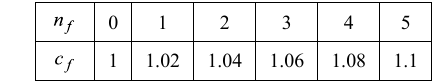
Table 2. Variations of c